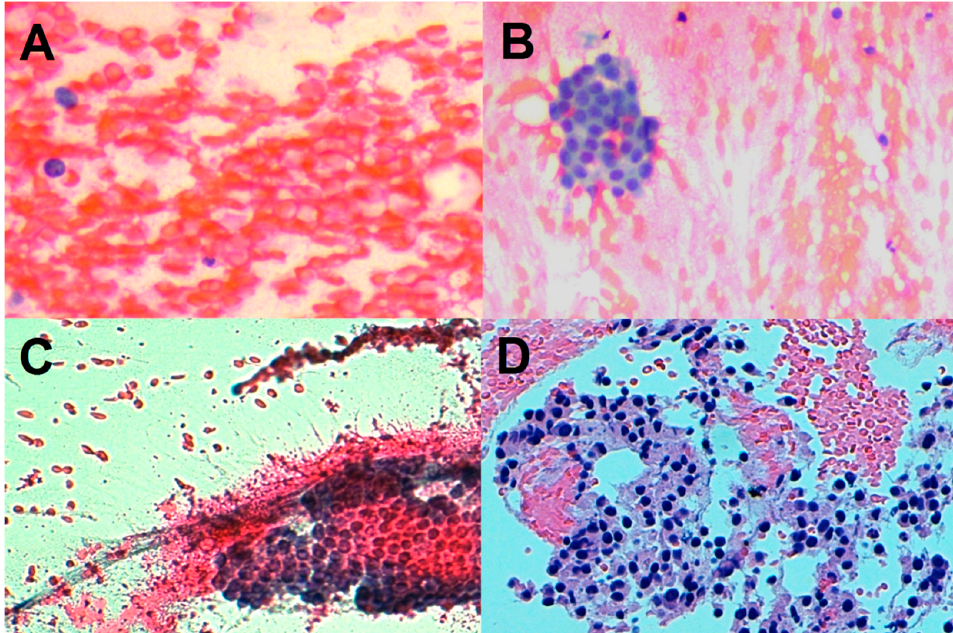
Figure 1. Adequacy score. ( A ): inadequate specimen (exclusively blood sample devoid of epithelial cellularity). ( B ): low cellularity (a small aggregate of epithelial cells in blood sample). ( C ): moderate cellularity (a clearly visible cellular cluster with preserved architecture, without atypia). ( D ): rich cellularity (cellular neoplastic clusters with atypical hyperchromic nuclei, punctiform necrosis, and apoptotic bodies).